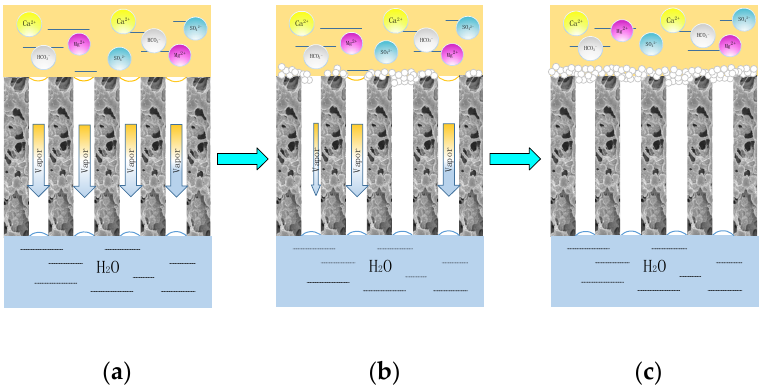
Figure 6. Inorganic fouling mechanism of the membrane: ( a ) Not fouled, ( b ) Partially fouled, ( c ) Completely fouled.